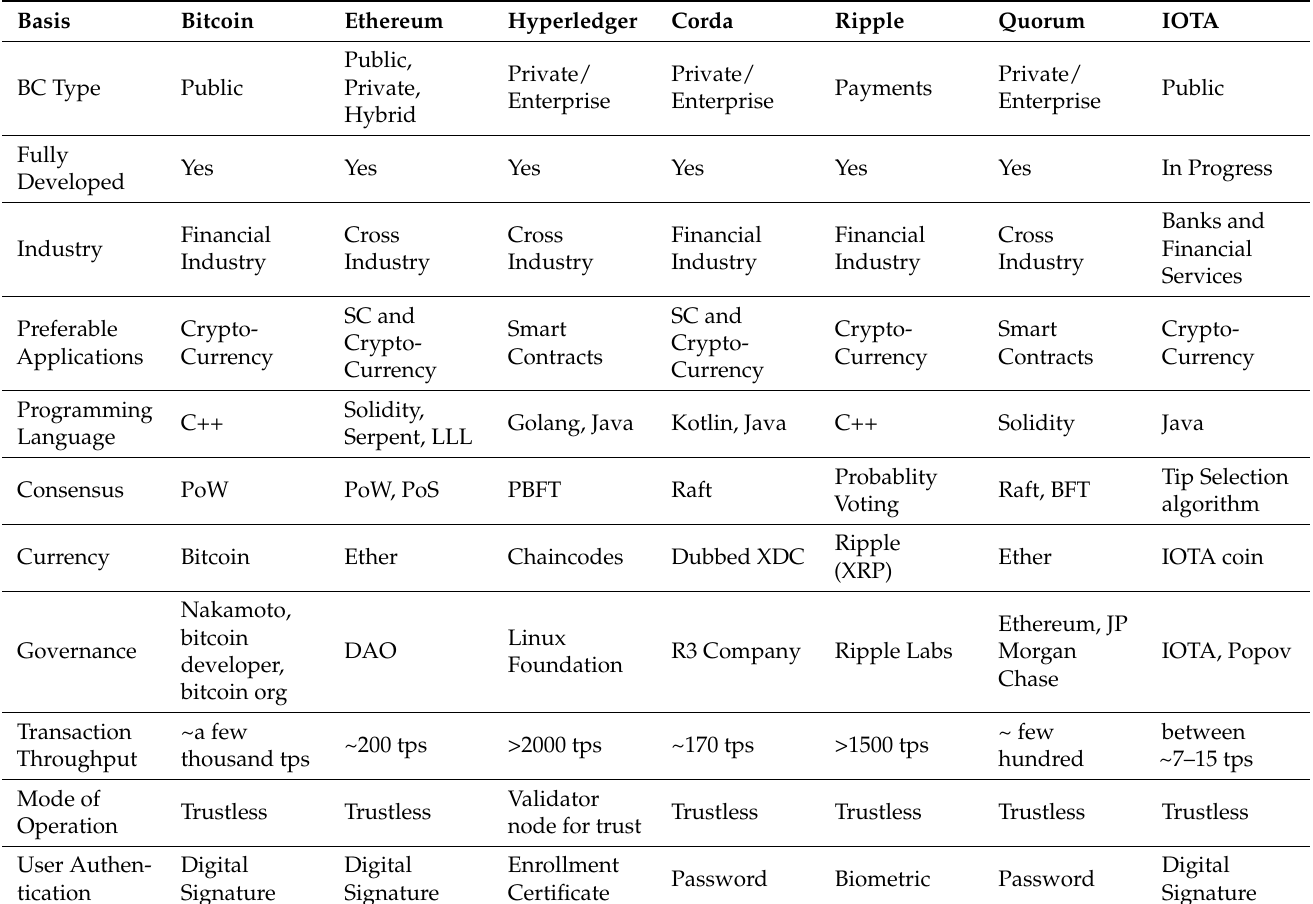
Table 5. Comparison of popular BC development frameworks